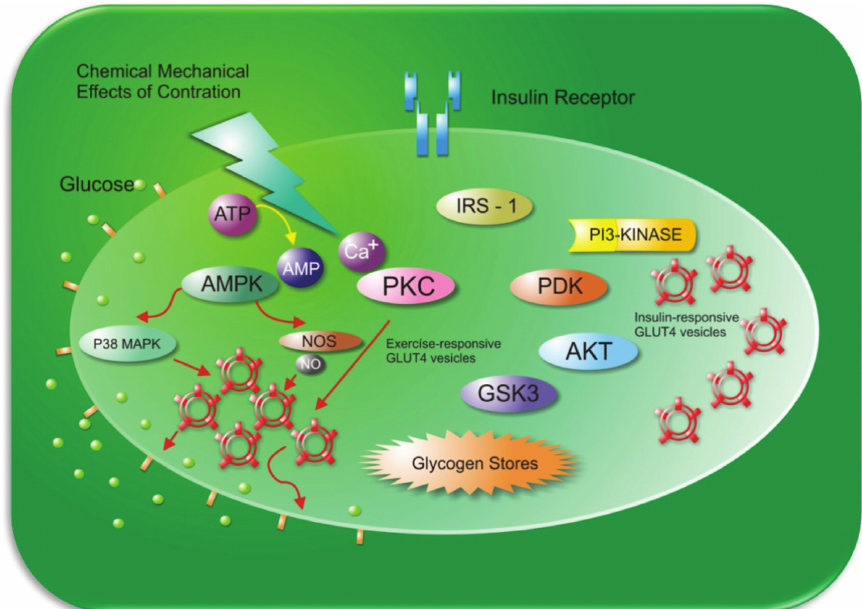
FIGURE 1 - Mechanisms evolved in the acute exercise-induced glucose transport. (Hayashi, Wojtaszewski, Goodyear, 1997; Zierath,